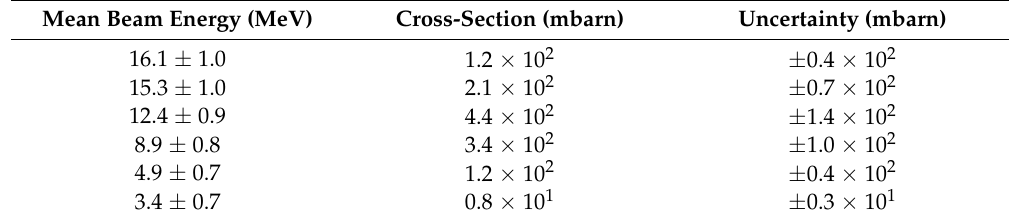
Table 3. Preliminary results of experimental cross-section values for 45 Sc (p,n) 45 Ti nuclear